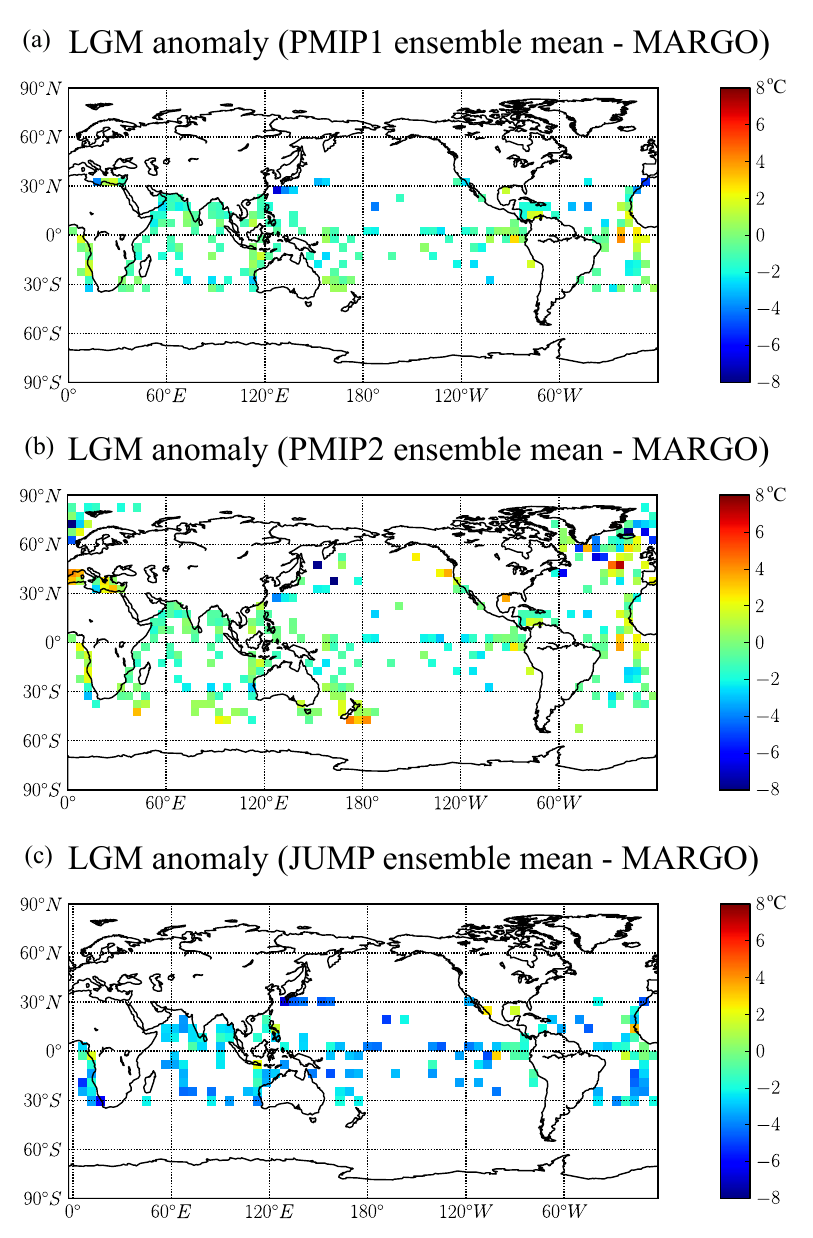
Fig. 4. The differences between the LGM anomalies for the model ensemble means and MARGO. (a) PMIP1, (b) PMIP2, (c) JUMP. The influence of the MARGO uncertainties is not included in these